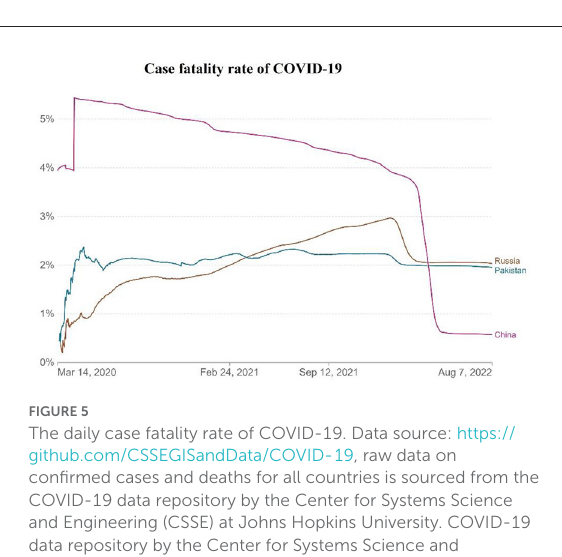
FIGURE5 The daily case fatality rate of COVID-19. Data source: https:// github.com/CSSEGISandData/COVID-19, raw data on confirmed cases and deaths for all countries is sourced from the COVID-19 data repository by the Center for Systems Science and Engineering (CSSE) at Johns Hopkins University. COVID-19 data repository by the Center for Systems Science